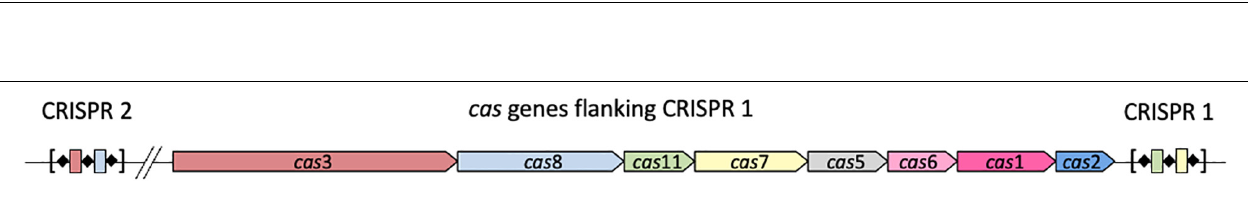
Frontiers in Microbiology |